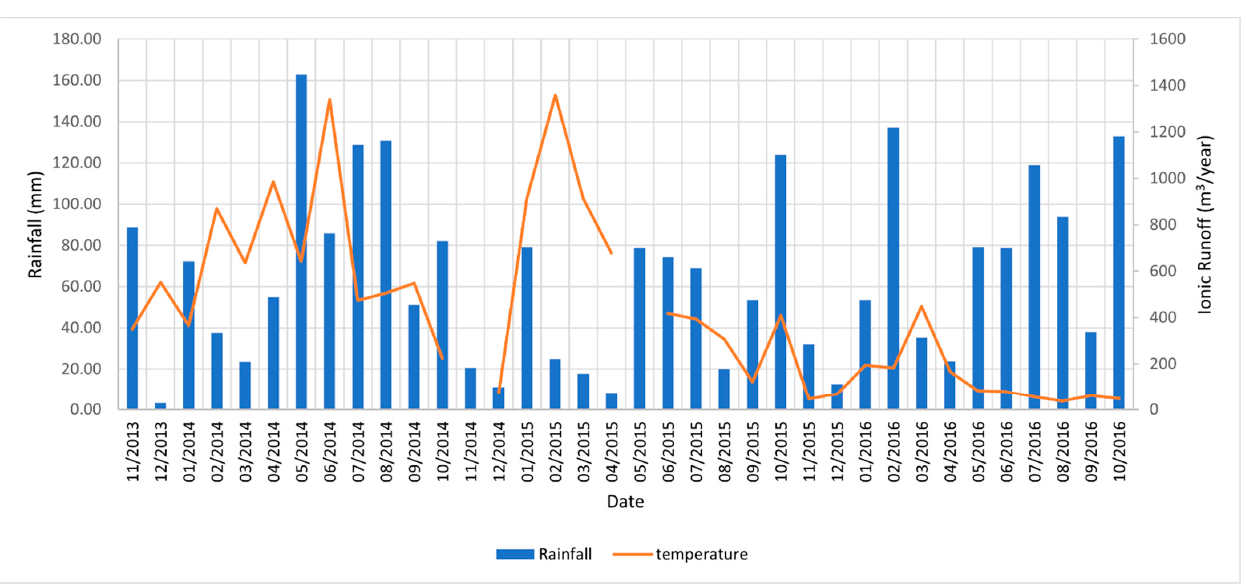
Figure 7. Relationship of rainfall and average ionic runoff of Jasov Plateau.